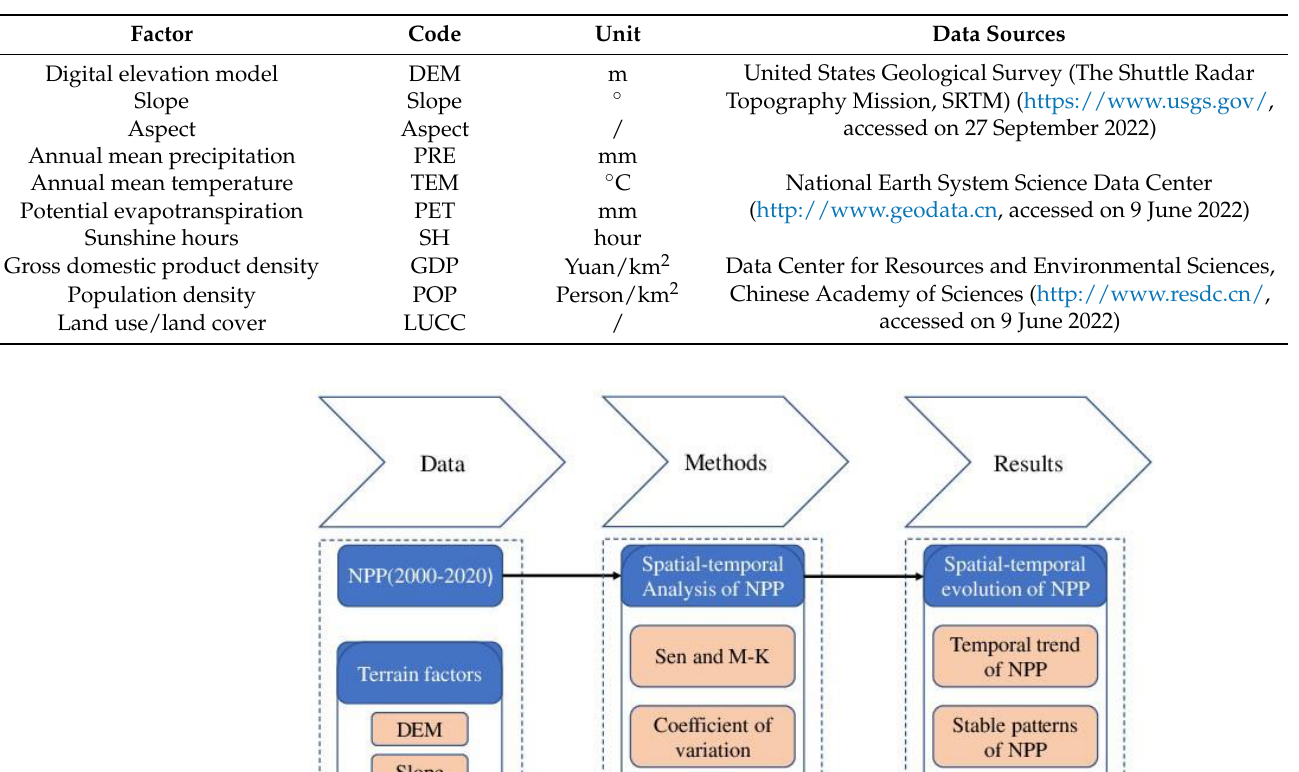
Table 1. Driving factors of NPP.